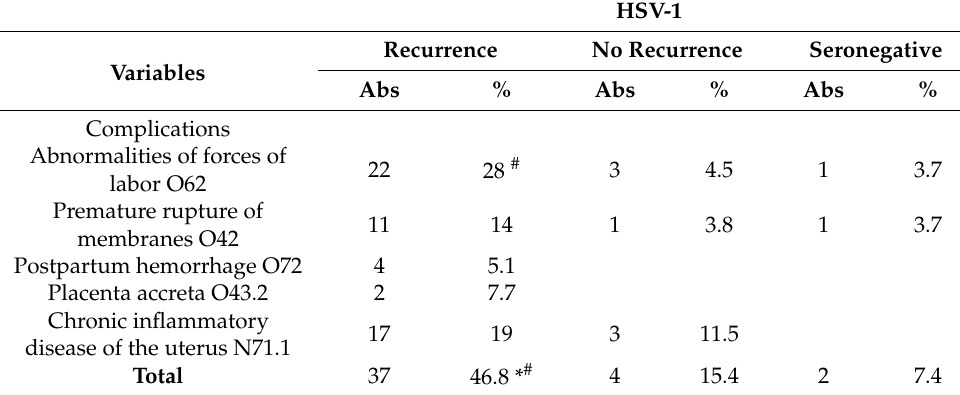
Table 8. The frequency and structure of complications in childbirth in the study groups.